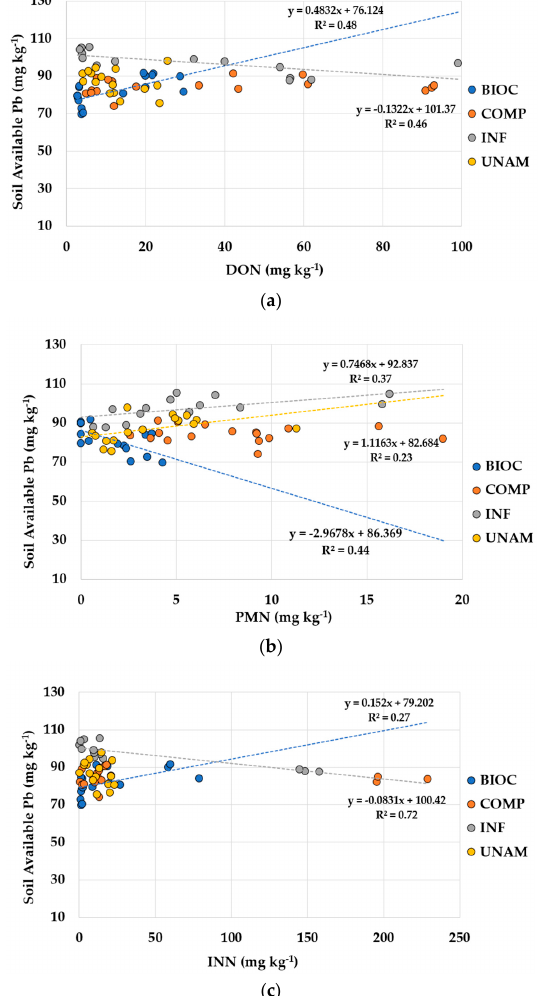
Figure 6. Relationship between soil available lead (Pb) and soil nitrogen parameters: ( a ) dissolved organic nitrogen (DON); ( b ), potentially mineralizable N (PMN); and ( c ) and inorganic N (ammo-